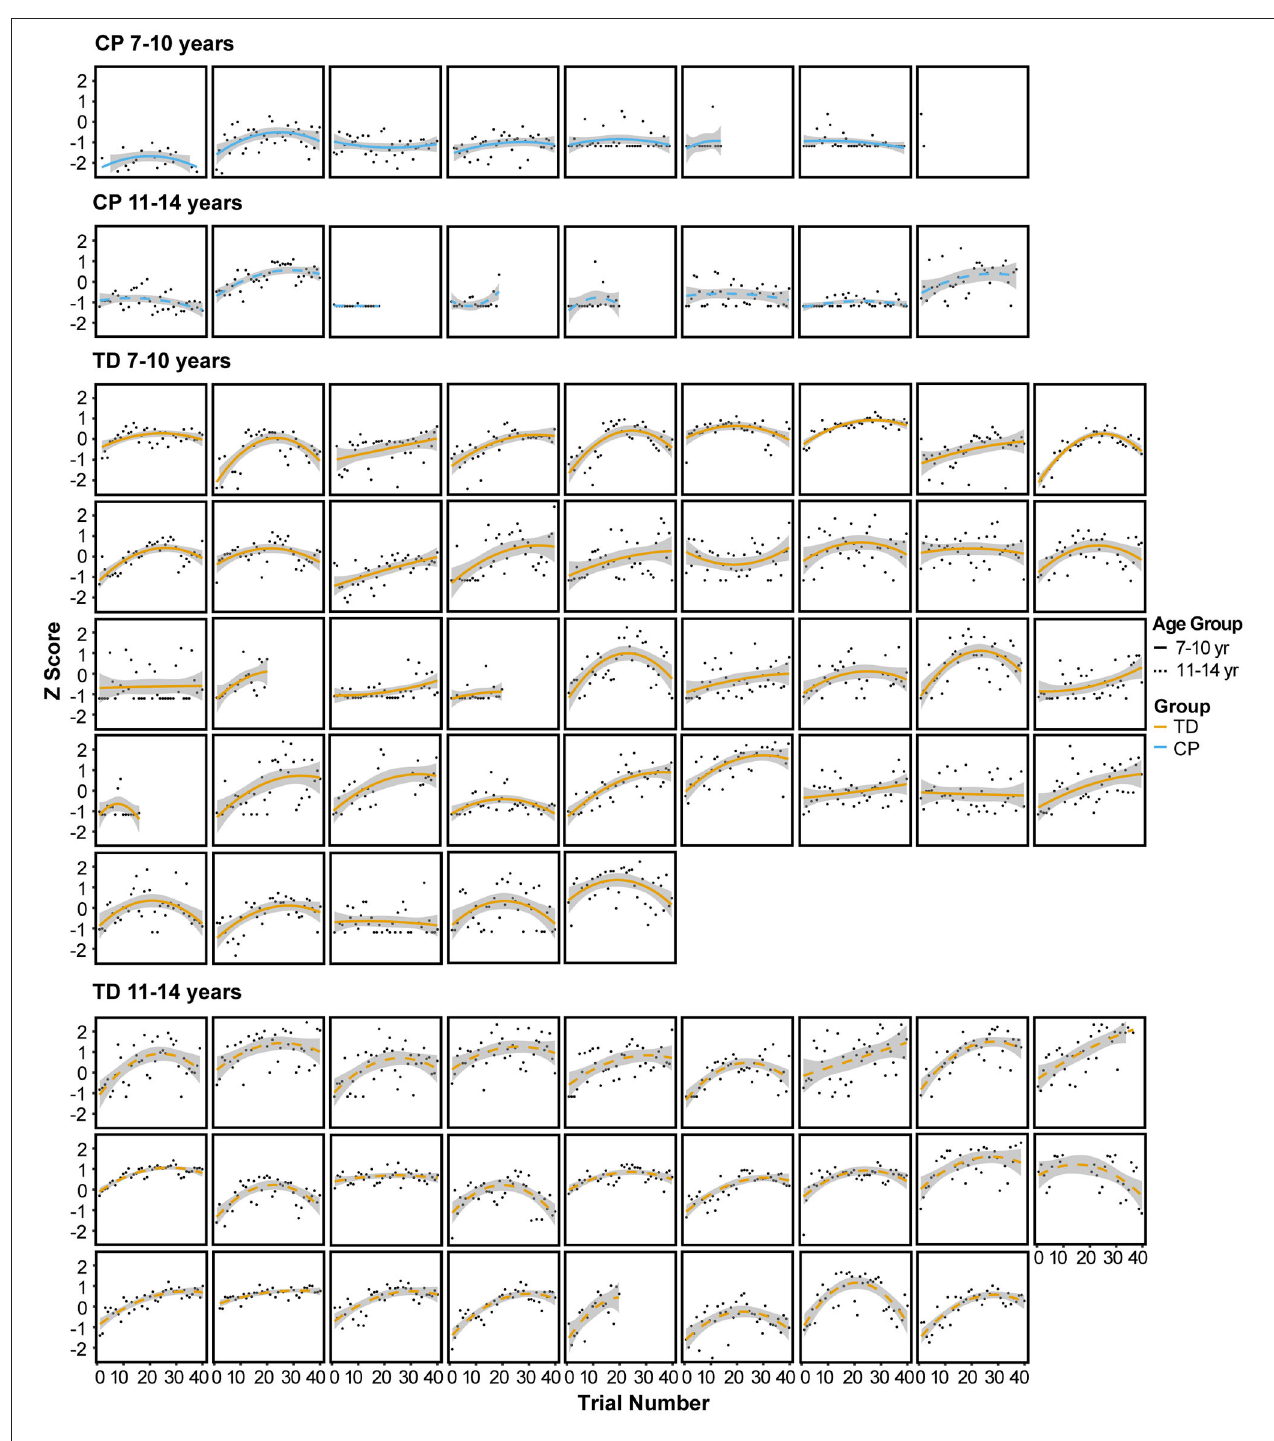
FIGURE 4 | Performance score for each individual participant across all trials of the 3 sessions, fit with a quadratic curve.